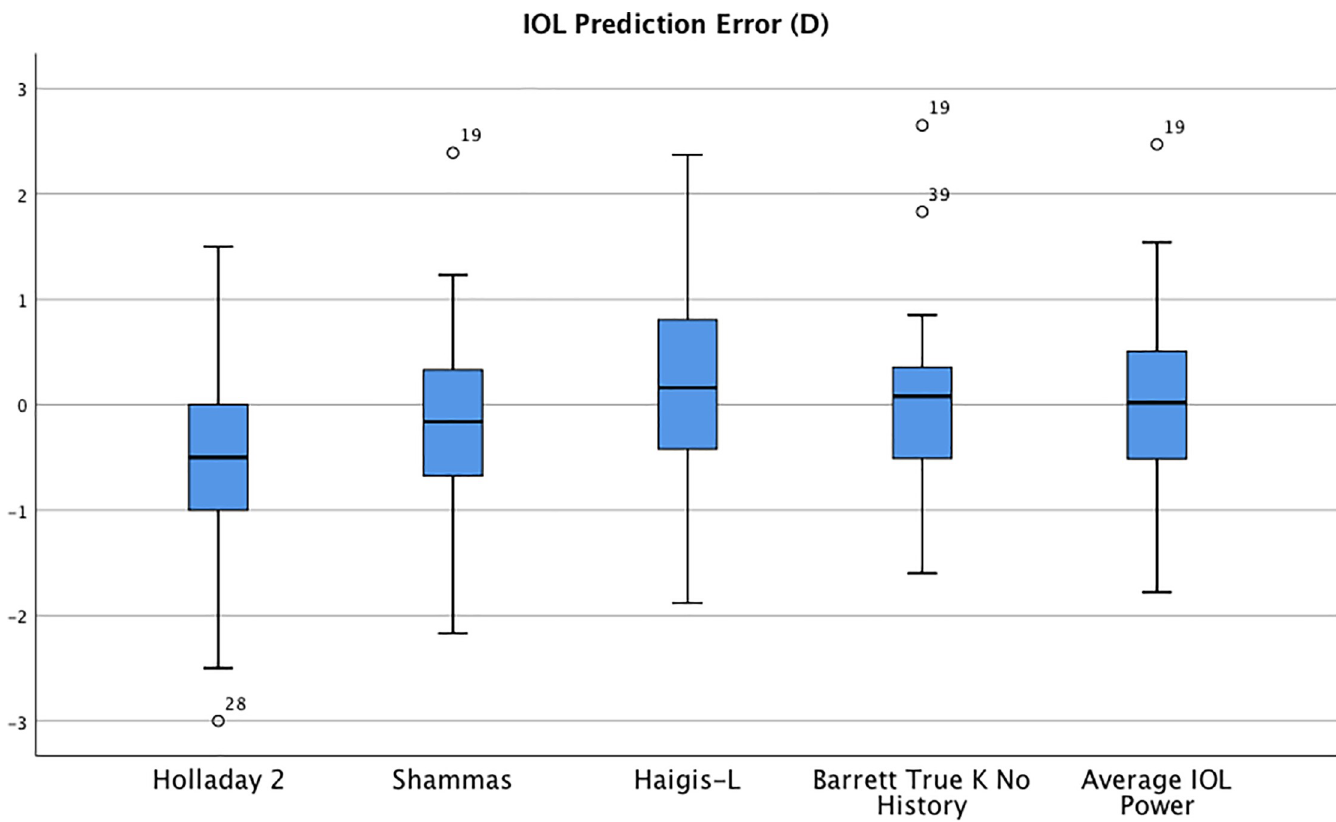
Fig 2. Box Plot of IOL power prediction errors with different IOL power calculation